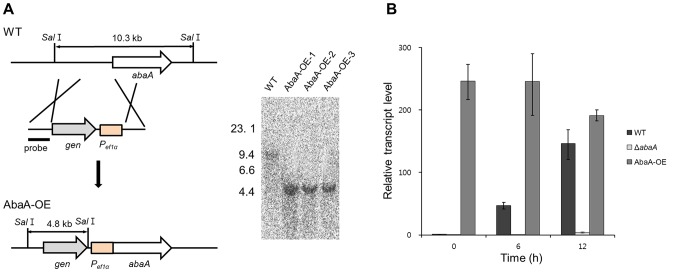
Overexpression of abaA.(A) The abaA promoter was replaced with the ef1α promoter. The left and right panels show the strategy of AbaA-OE strain construction and Southern hybridization, respectively. The sizes of DNA standards (kb) are indicated on the left of the blot. (B) Relative transcript accumulation of abaA in wild-type, abaA-deleted, and abaA-overexpressed strains. The transcript level of abaA was analyzed by quantitative real time-PCR (qRT-PCR) during the conidium induction stage. WT, F. graminearum wild-type strain Z-3639; ΔabaA, abaA deletion mutant; AbaA-OE, a transgenic strain with the abaA promoter replaced with the ef1α promoter.